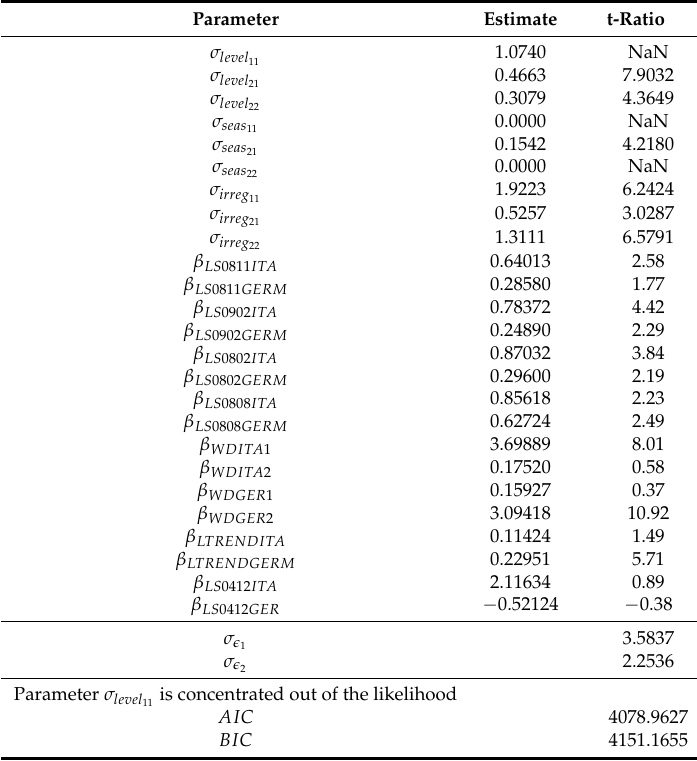
Table A9. Endogenous variables: IPI t capital goods TTMI t in